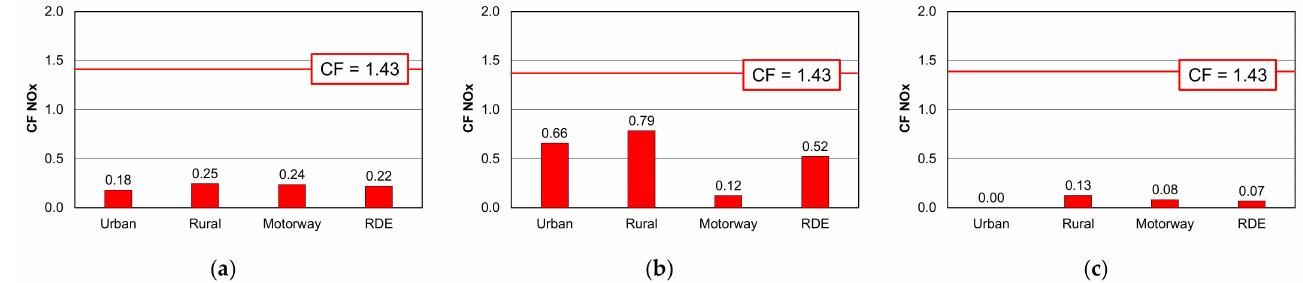
Figure 12. Conformity factors for nitrogen oxides emission achieved in respective parts of the tests in a passenger vehicle with a gasoline engine ( a ), a diesel engine ( b ), PHEV ( c ).